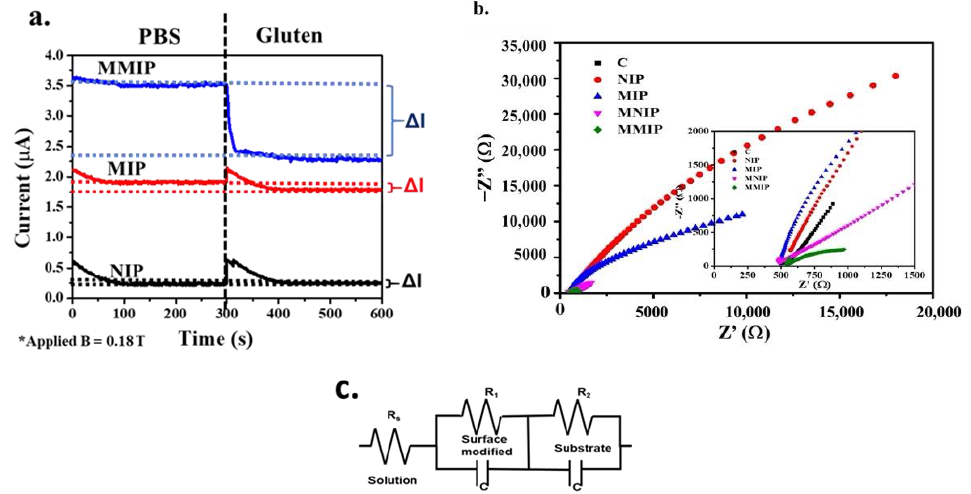
Figure 3. Electrochemical behaviors of MMIP-, MIP-, and NIP-modified electrodes analyzed via amperometry ( a ) and impedance spectroscopy ( b ). EIS circuit of the MMIP electrode ( c ).